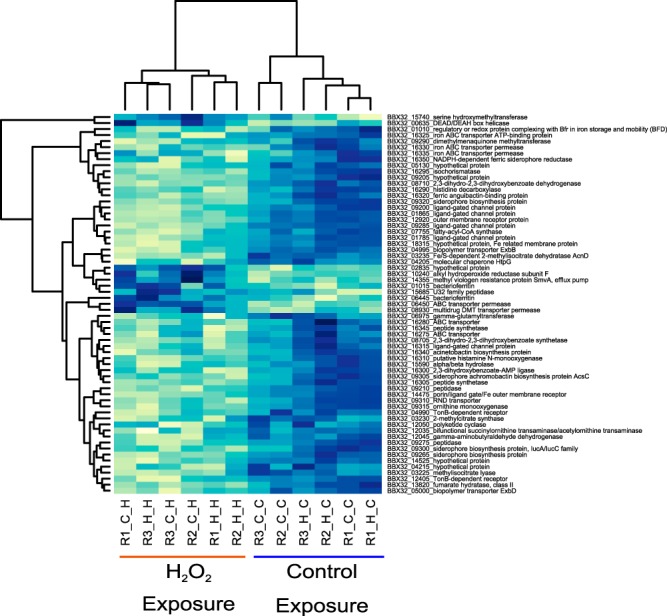
Heat map of differentially expressed genes. Expression levels of the 64 differentially expressed genes are shown as the variance-stabilizing transformed (VST) read count data from DESeq2 (18). Each sample is named with the replicate number, the serial passage subculture condition, and the 30-min exposure condition. For example, R1_H_H indicates replicate 1 grown in H2O2-amended LB and treated with a brief H2O2 exposure.